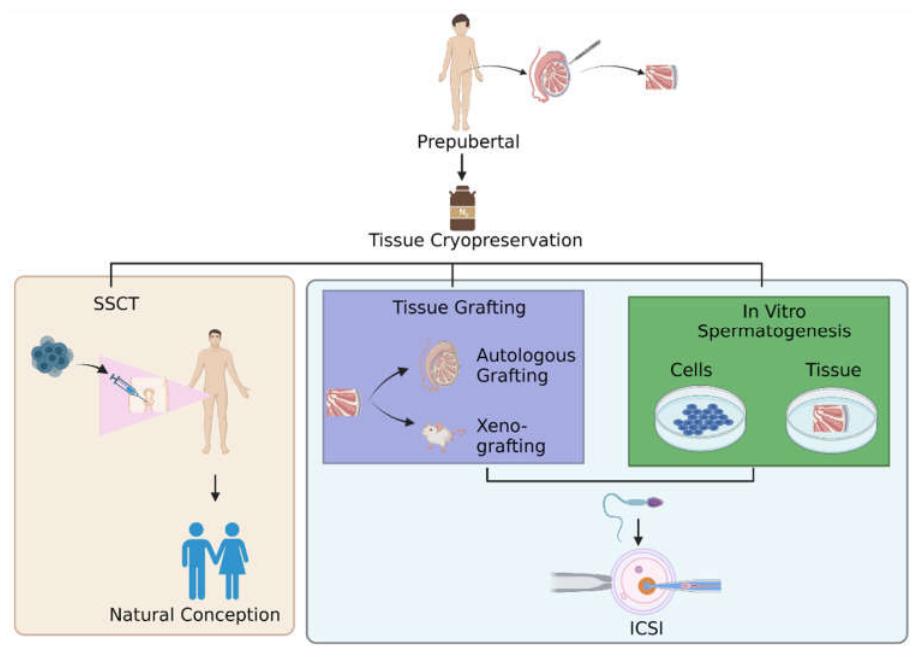
Figure 1. Pathways for restoring fertility. After the thawing step in cryopreservation of testicular tissue, there are three options for men to restore fertility: undergoing SSCT, testicular tissue grafting, or in vitro spermatogenesis. Abbreviation: SSCT; spermatogonial stem cells transplantation, ICSI; intracytoplasmic sperm injection.